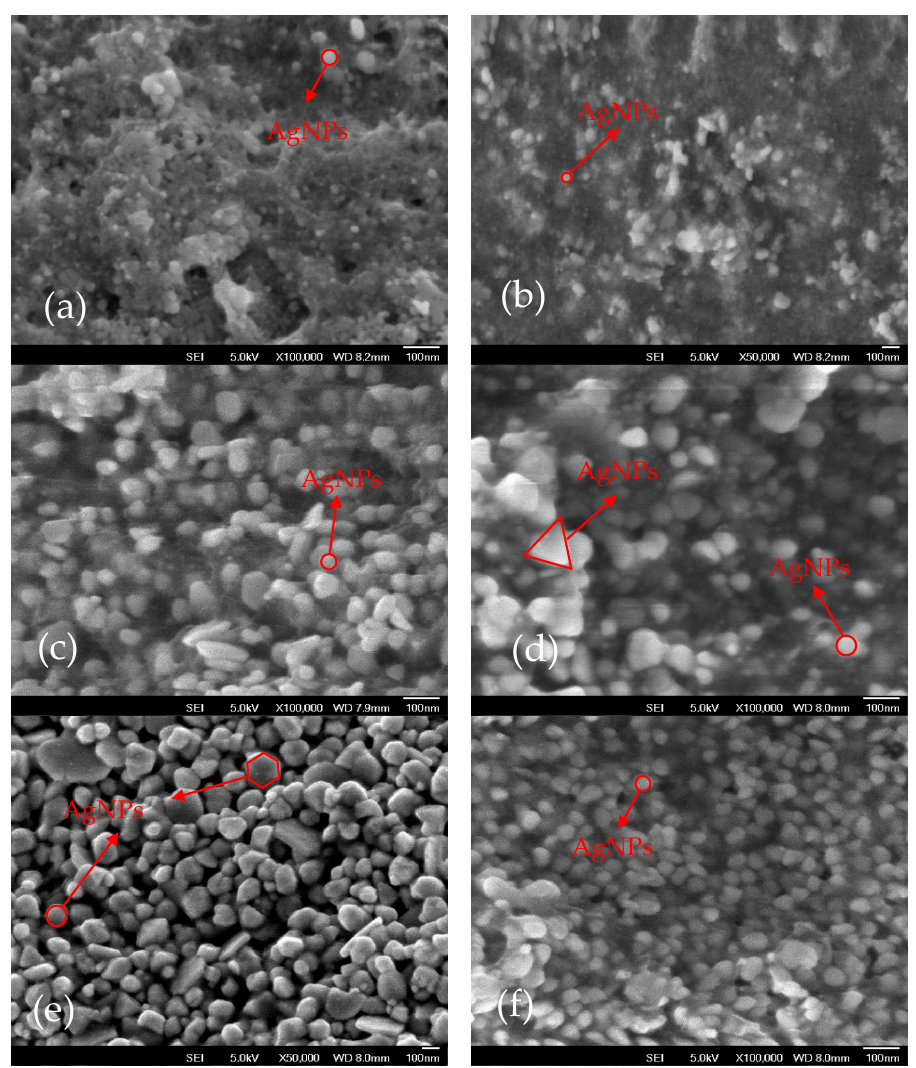
Figure 4. FESEM of AgNPs synthesized using ( a ) Cyperus rotundus ; ( b ) Eleusin indica ; ( c ) Euphorbia hirta ; ( d ) Melastoma Malabathricum ; ( e ) Clidemia hirta ; and ( f ) Pachyrhizus erosus